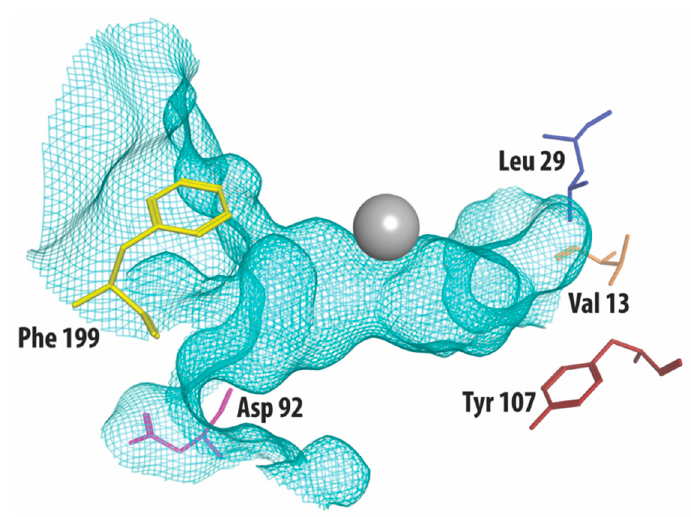
Figure 1. The crystal structure of HDAC3 (PDB code: 4A69, mesh indicates the catalytic site surface) showing only the amino acid residues that differ from HDAC1 and HDAC2 (presented as stick structures). The zinc required for catalysis is shown in grey.